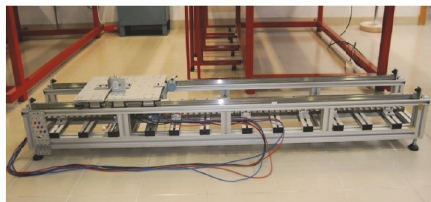
Figure 1: General view of the real LSRA considered in this